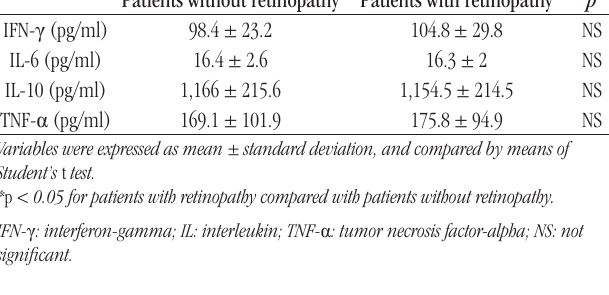
taBLE 6 − Cytokines of type 1 diabetes patients classified according to the presence or absence of retinopathy Patients without retinopathy Patients with